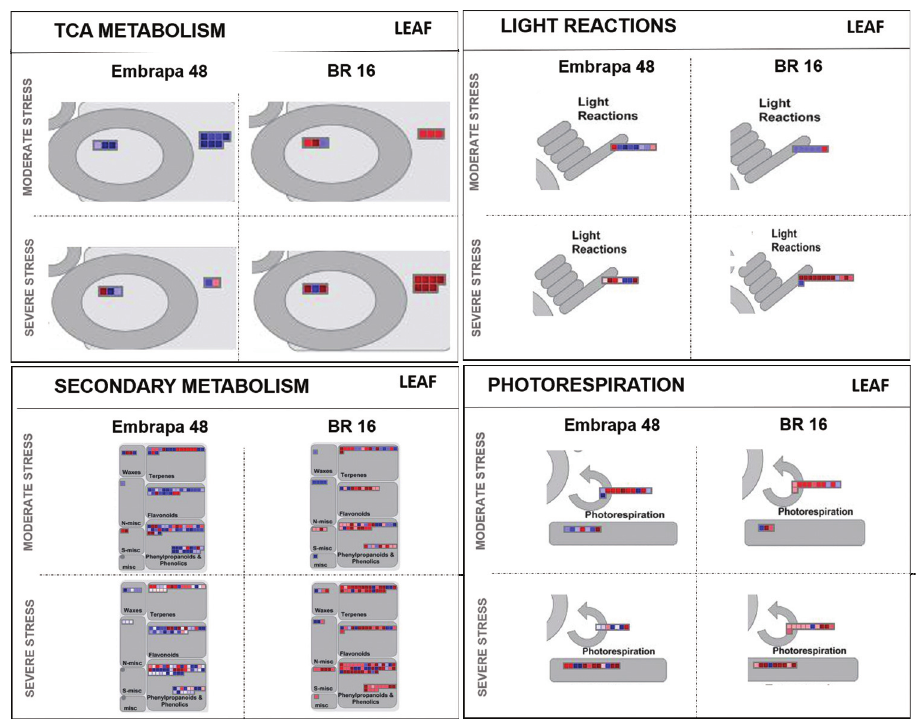
Figure 6 - Metabolism overview mapping (MapMan 3.6 ORC). Genes that were differentially expressed in response to water deficit were mapped to spe- cificstress-relatedgenegroups(TCAandsecondarymetabolism,lightreactionsandphotorespiration)forleaffromEmbrapa48andBR16undermoder- ate and severe stress. The color scale shows the log2 fold-change: red = down-regulated and blue = up-regulated.